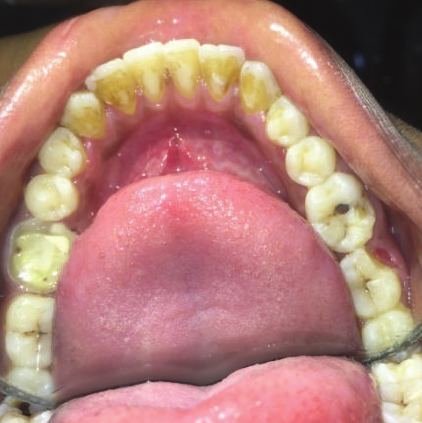
Figure 19: Inlay casting try-in on the cast with respect to 37.